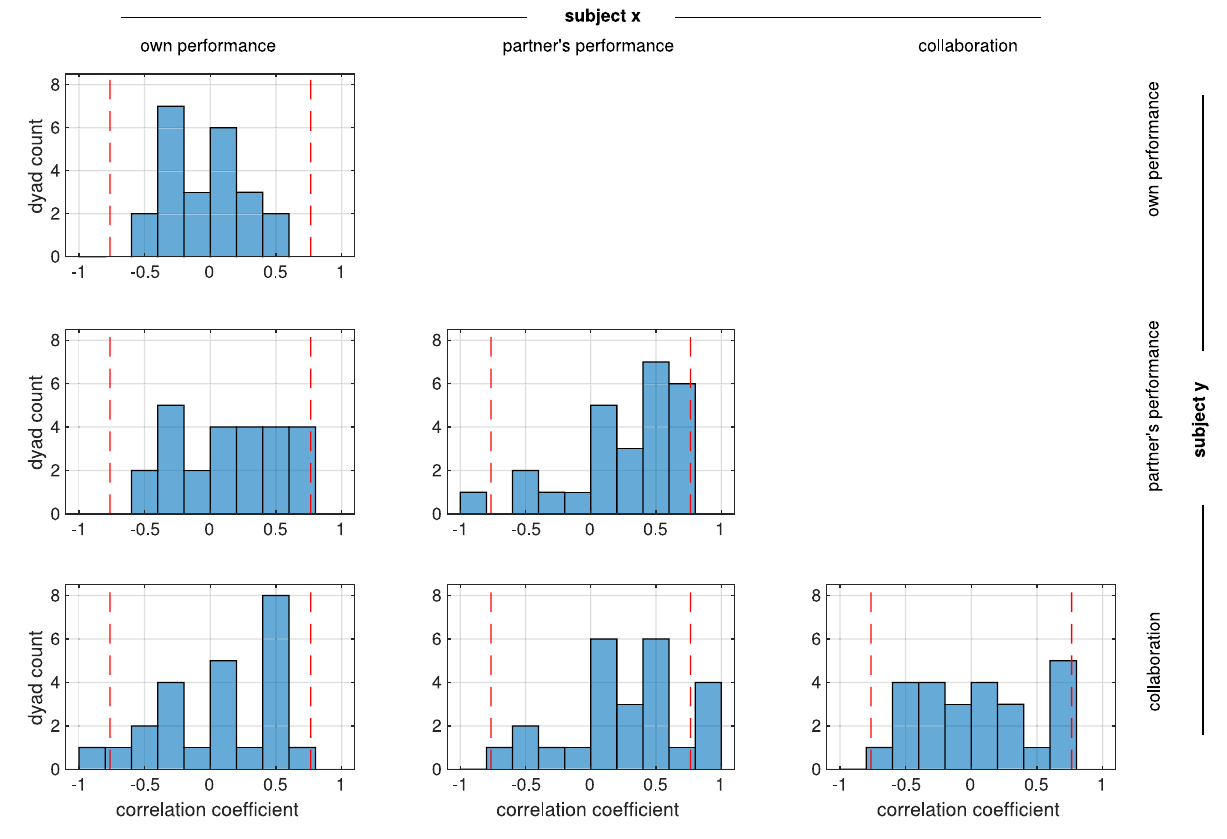
FIGURE 3 | Distribution of correlation coefficients between the ratings from the two partners in each dyad. All possible correlations were calculated, e.g., the top panel shows the correlation coefficients between the ratings of own performance (R1) from the two partners. Red dashed lines mark the strength beyond which correlations are significant ( p < 0.05, FDR-corrected).